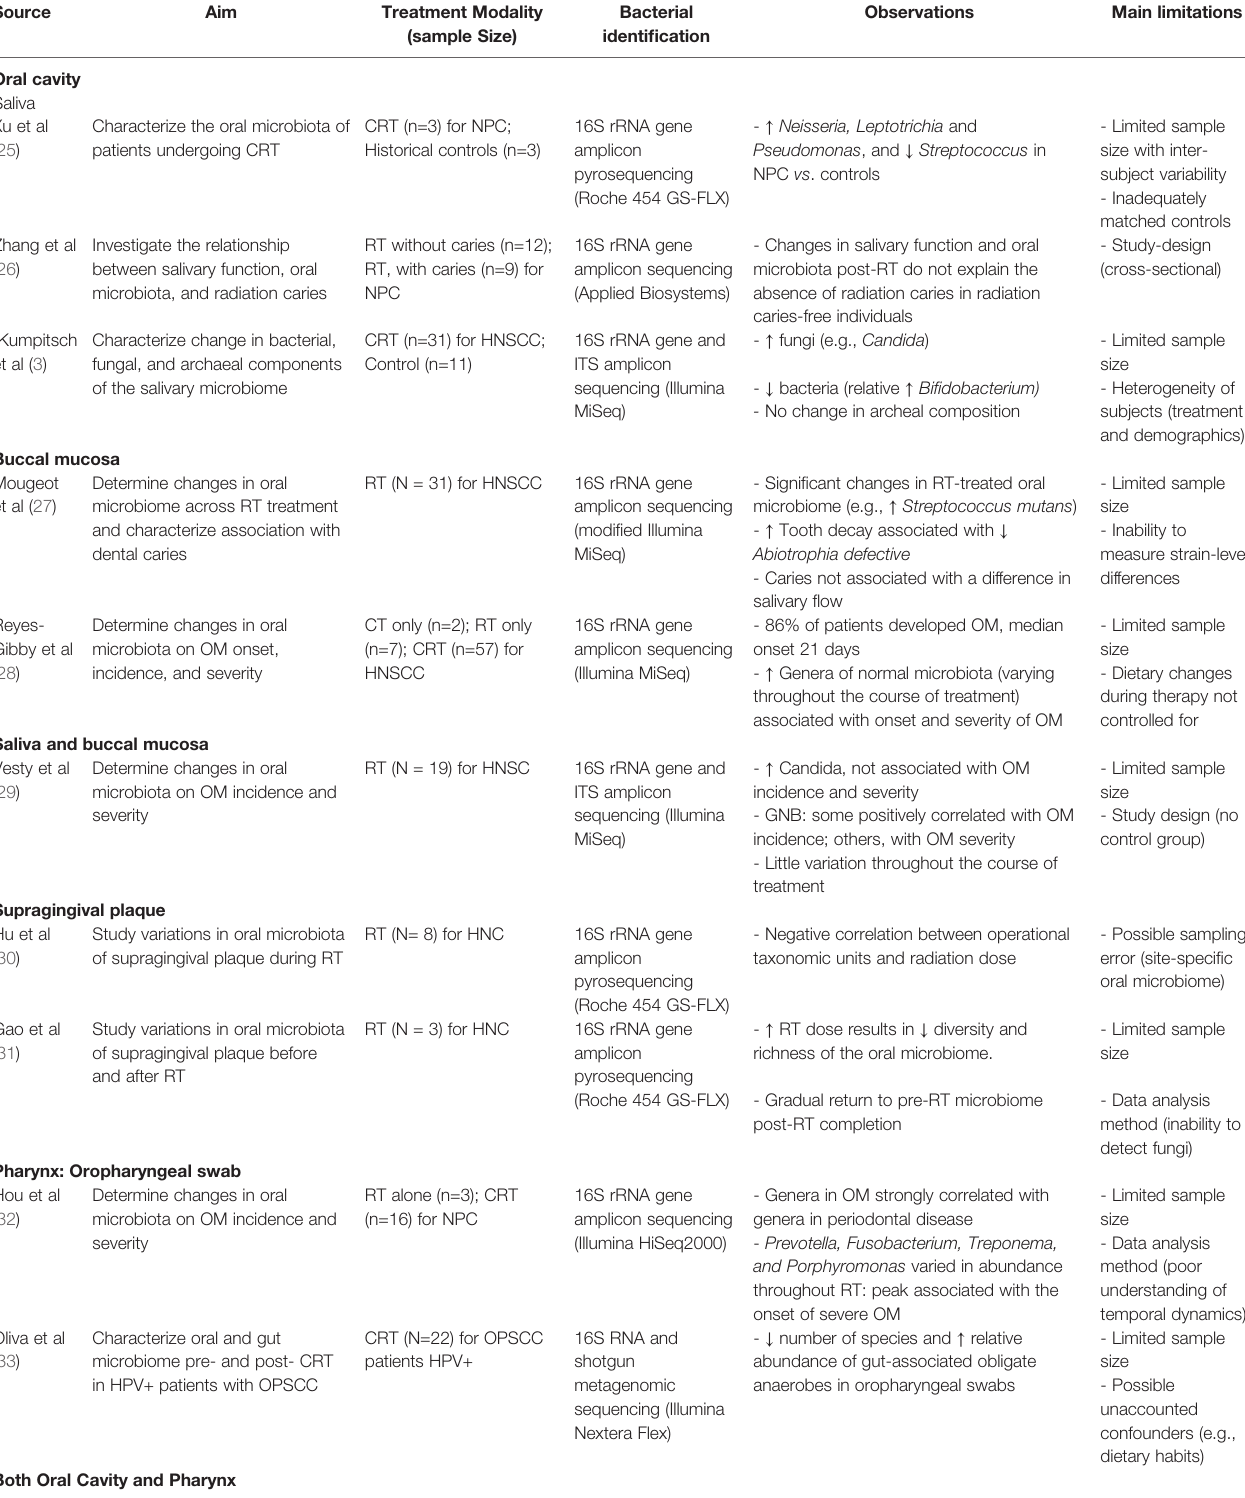
TABLE 2 | Impact of Radiation or Chemoradiation Therapy on the Head and Neck